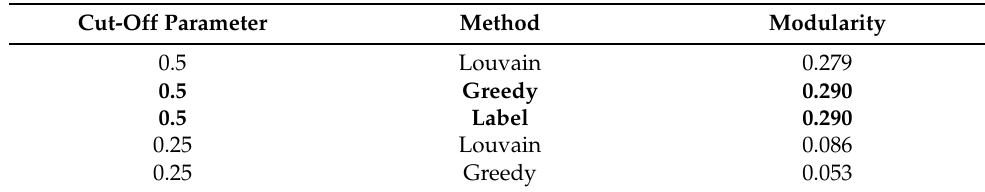
Table 10. Modularity values for different graph methods and different cut-off parameters (wholesale